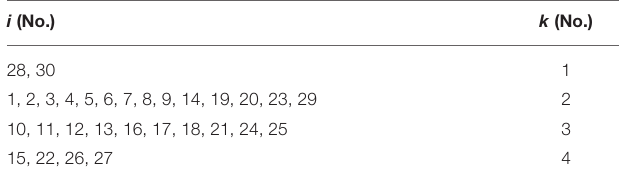
TABLE 7 | Allocation results according to Model